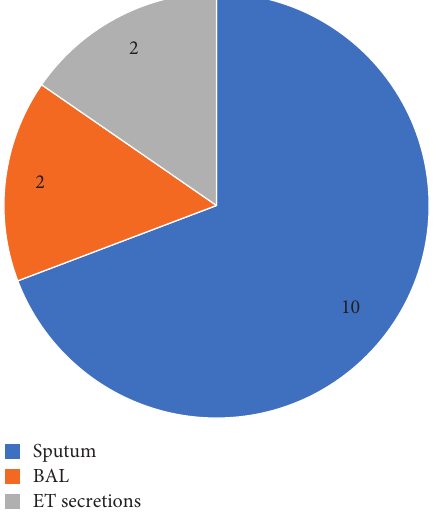
Figure 2: Pie chart showing sample